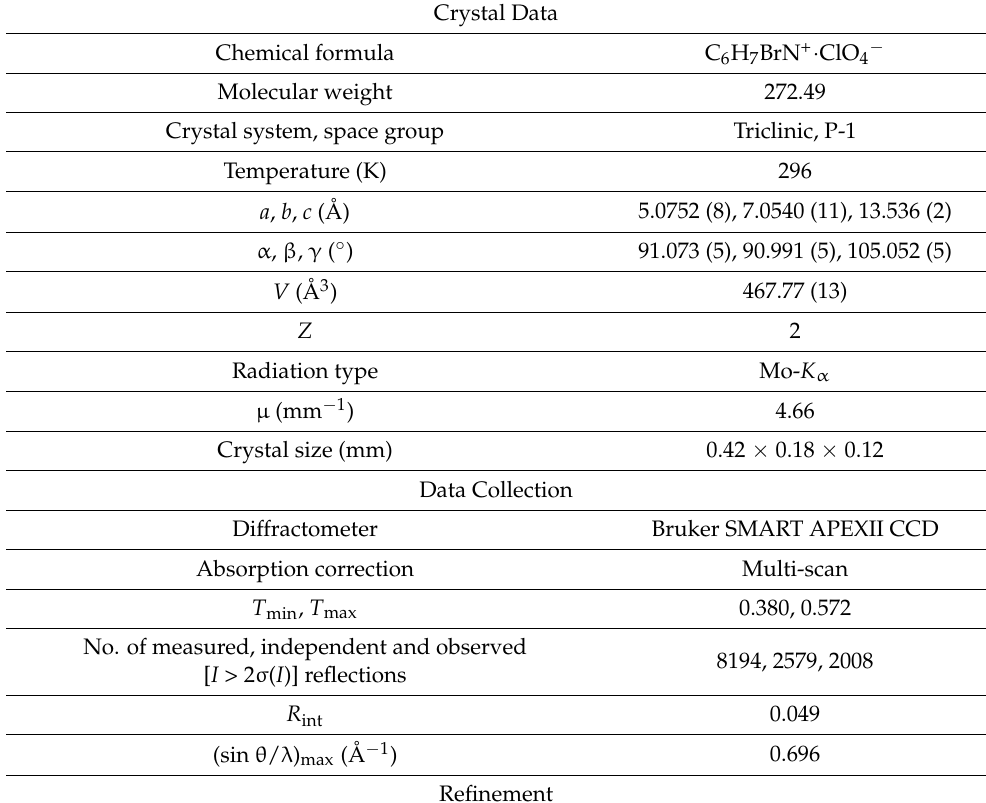
Table 1. Crystallographic data and structure refinement parameters of